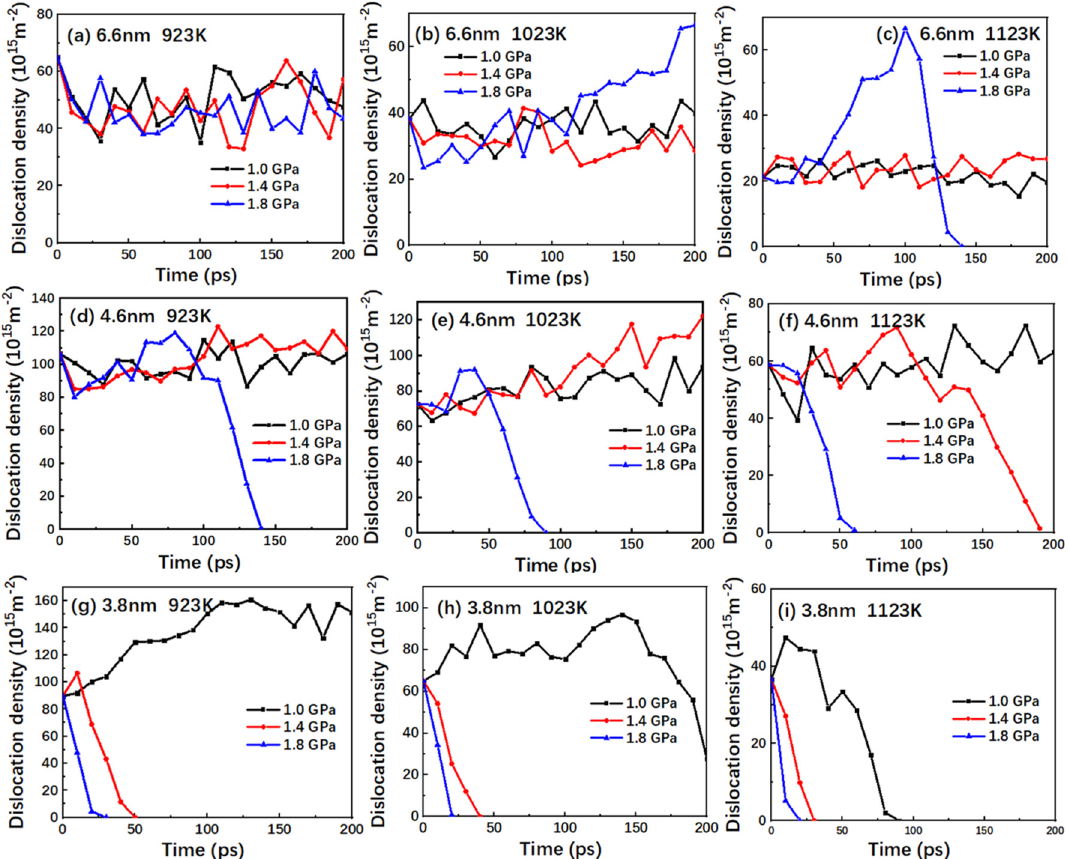
Figure 5. Plots of the dislocation density versus time for the nanocrystalline TiAl models with grain sizes of ( a ) 6.6 nm at 923 K; ( b ) 6.6 nm at 1023 K; ( c ) 6.6 nm at 1123 K; ( d ) 4.6 nm at 923 K; ( e ) 4.6 nm at 1023 K; ( f ) 4.6 nm at 1123 K; ( g ) 3.8 nm at 923 K; ( h ) 3.8 nm at 1023 K; and ( i ) 3.8 nm at 1123 K under the stress levels of 1.0, 1.4, and 1.8 GPa.